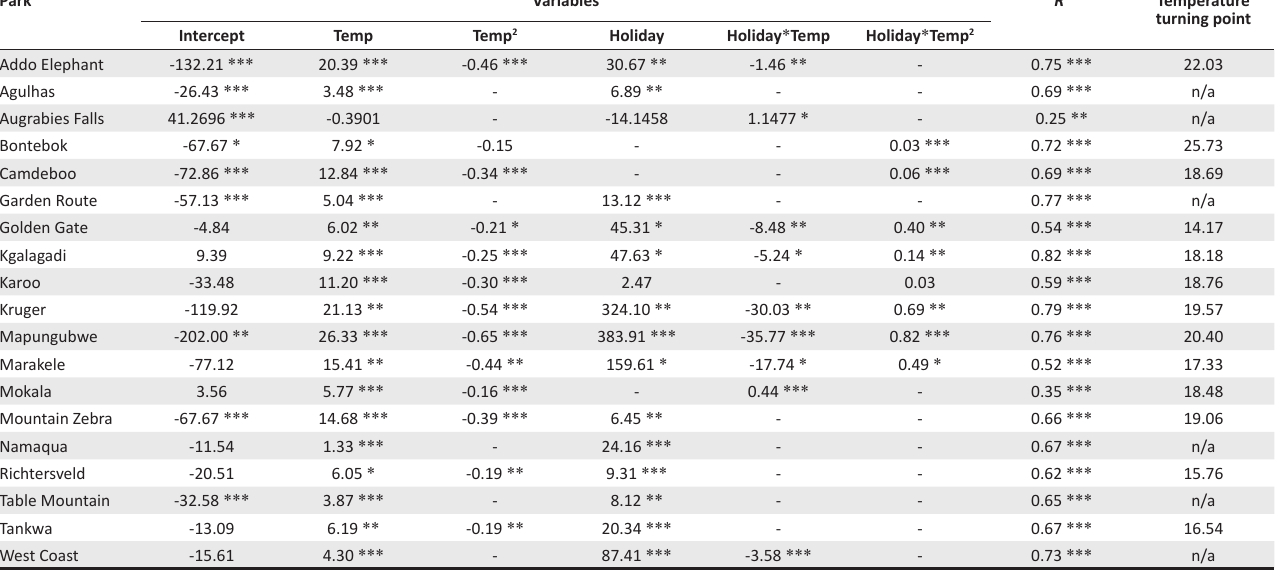
TABLE 2: Results of the statistical analysis, indicating the best-fit model for each park. For the parks exhibiting a quadratic function, the temperature turning point is also shown. Significance: < 0.001 *** , < 0.01 ** , < 0.05 *